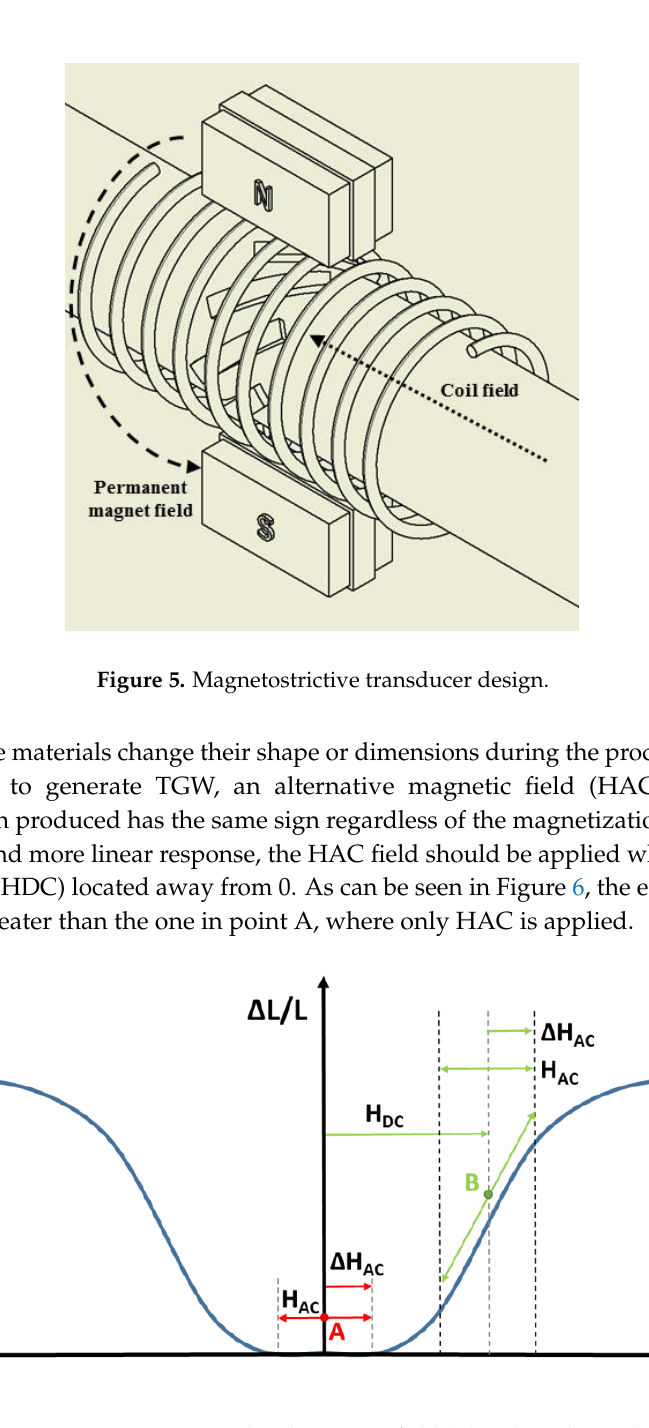
Figure 6. Typical magnetostrictive curve-related magnetic field (H) and mechanical strain ( ∆ L/L) [13].